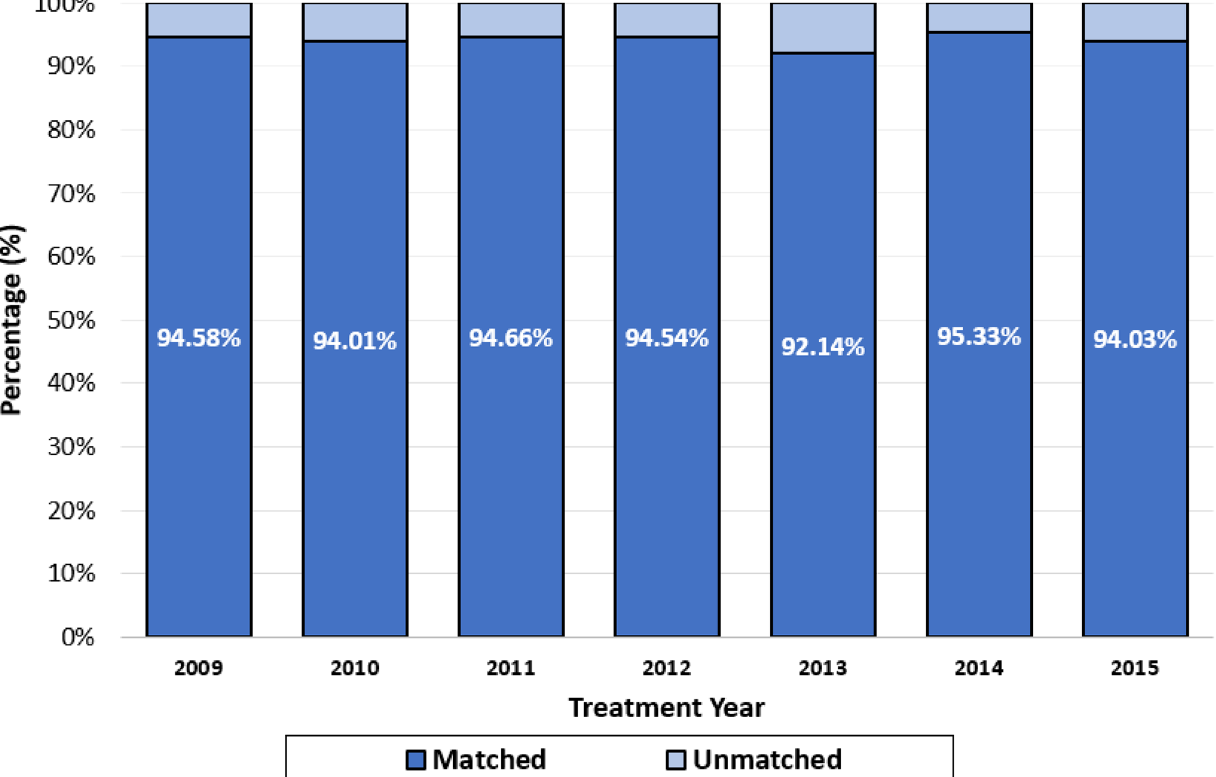
Figure S1: Overall concordance rate 1 between ANZARD and New South Wales (NSW) and Australian Capital Territory (ACT) perinatal data collection data for the final linked data of the the medically assisted reproduction (MAR) data linkage for New